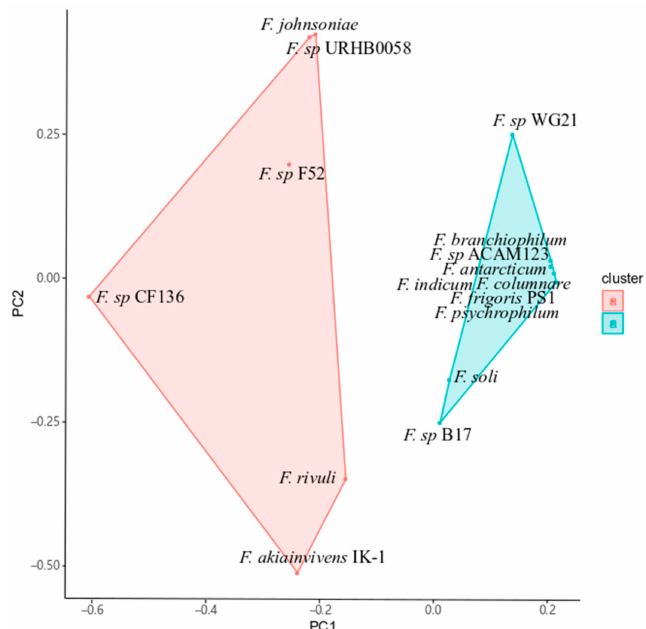
Figure 2. Two dimensional scatter plot based on carbohydrate-active enzyme (CAZy) classes in the terrestrial and aquatic flavobacteria. The matrix representing the presence and absence of the CAZy classes was imported into the R program. IK-1 T was clustered with members from the terrestrial clade of Flavobacteria (red). Members from the aquatic clade of Flavobacteria (blue) was clustered separately. The terrestrial and aquatic clades of Flavobacteria showed distinct distances in this two dimensional plot. The percentages of PC1 and PC2 are 84.9% and 8.49%, respectively. Red: terrestrial flavobacteria , blue: aquatic flavobacteria